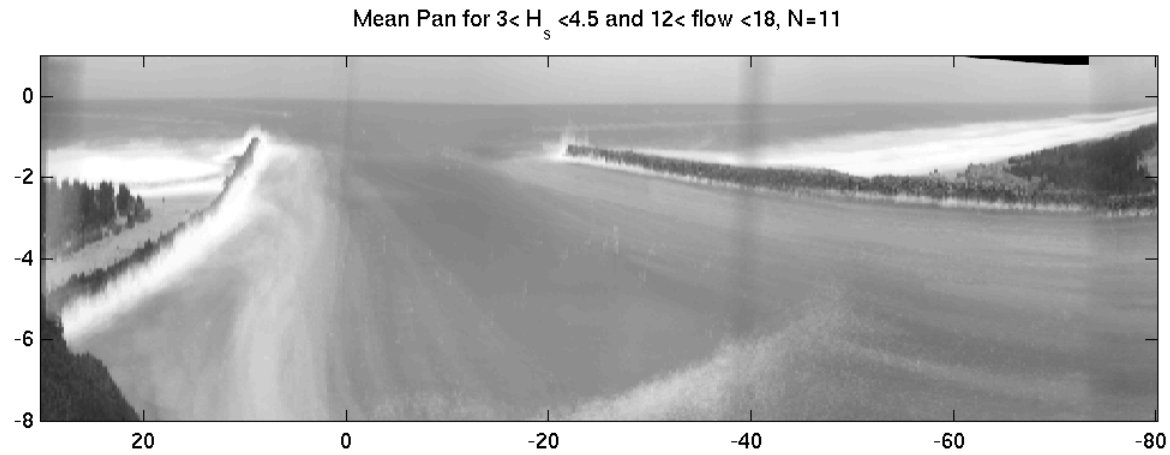
Figure 15. Bin-averaged “brightest” pan for wave heights between 3.0 and 4.5 m and spring flood flows. There is no longer any enhanced breaking in the inlet mouth and the breaking over Guano Rock is shifted landward by the flood flow in a more cross-channel linear direction.